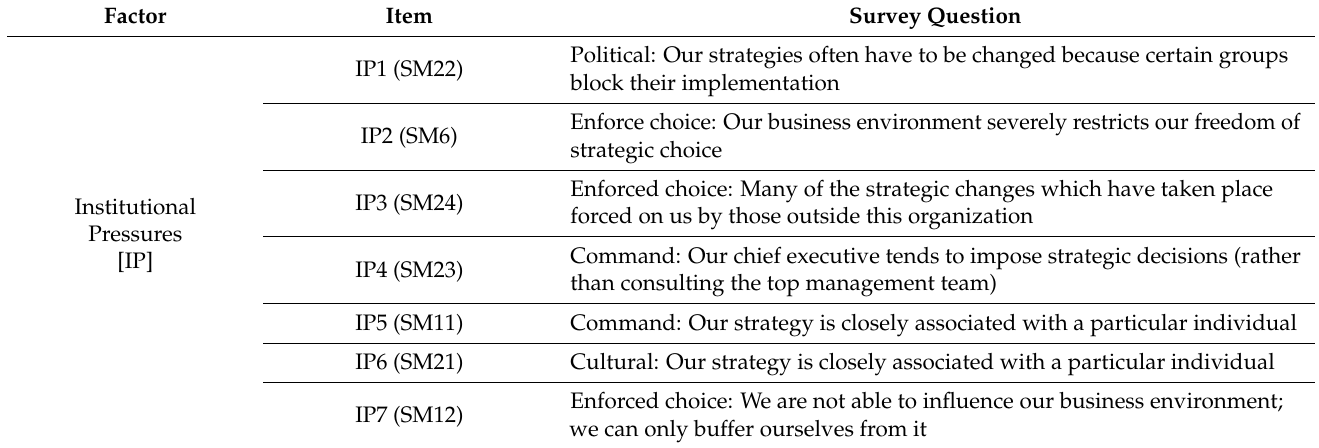
Table 4. Definition of new